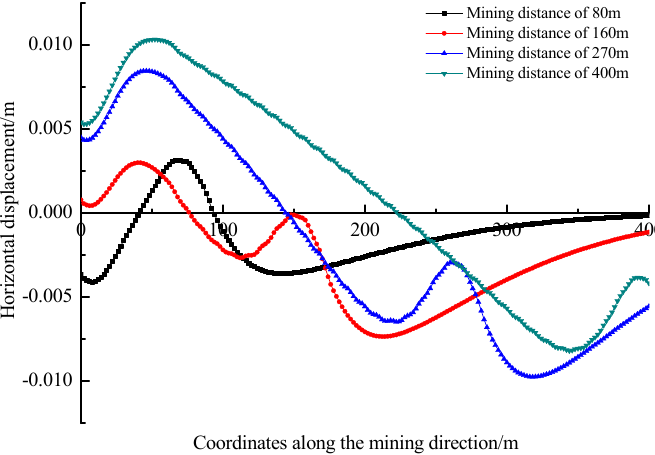
Figure 6. Horizontal displacement of the No. 3–5 coal seam while mining the No. 4 coal